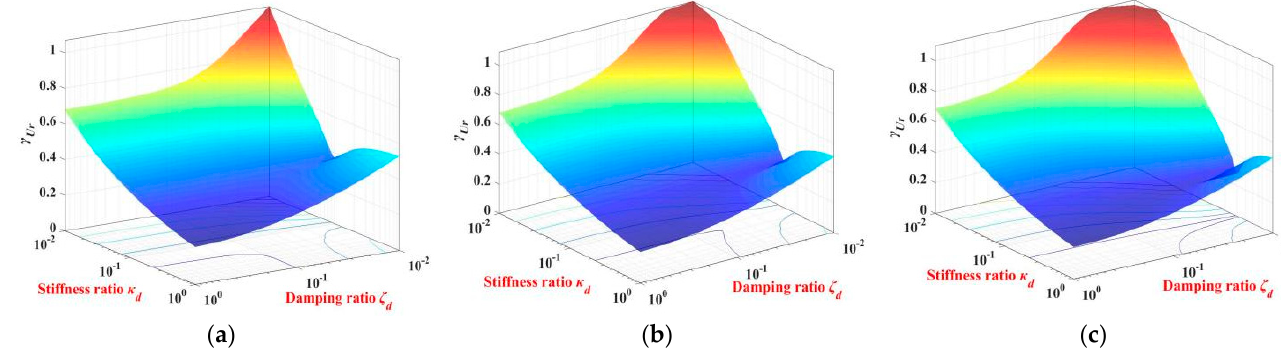
Figure 7. Contour plot of γ Ut of EC system: ( a ) μ d = 0.1; ( b ) μ d = 0.2; and ( c ) μ d = 0.3.